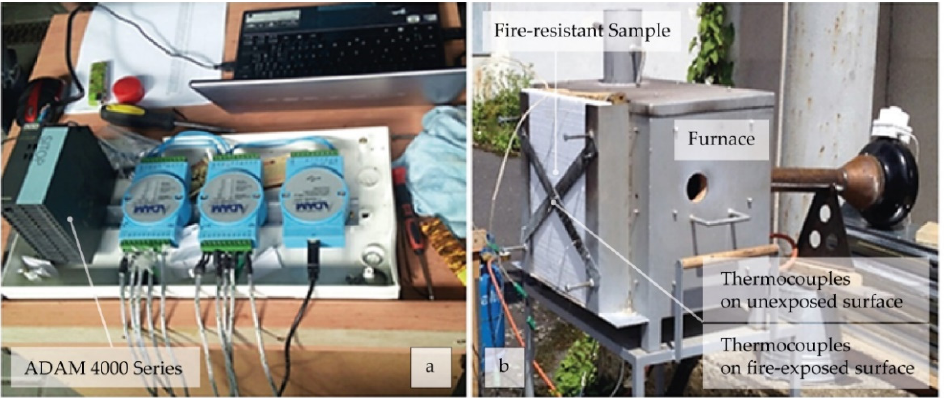
Figure 3. Equipment setup for monitoring the temperature variations: ( a ) ADAM 4000 Series and ( b ) internal (K5–K9) and external thermocouples (K1–K8).